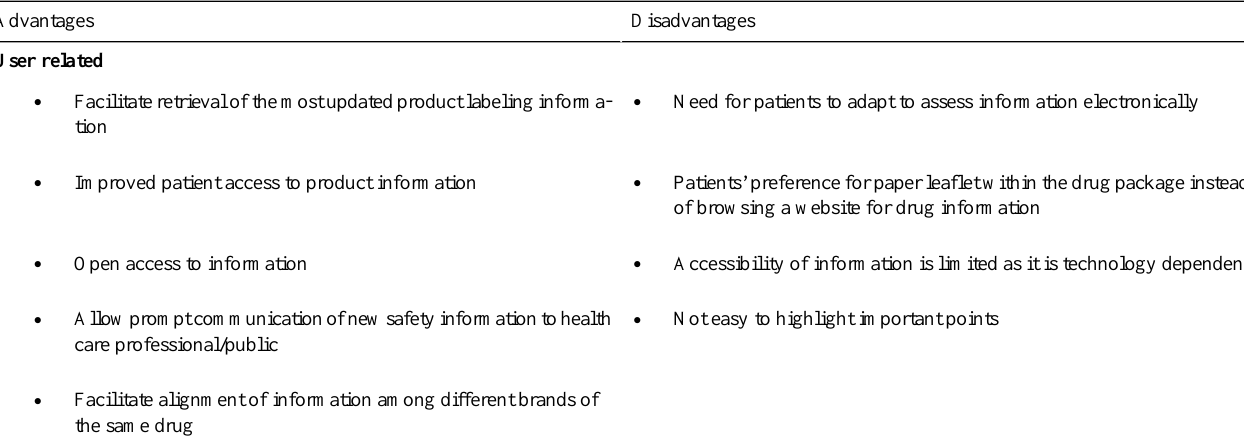
Table 3. Major advantages and disadvantages of electronic product information identified by